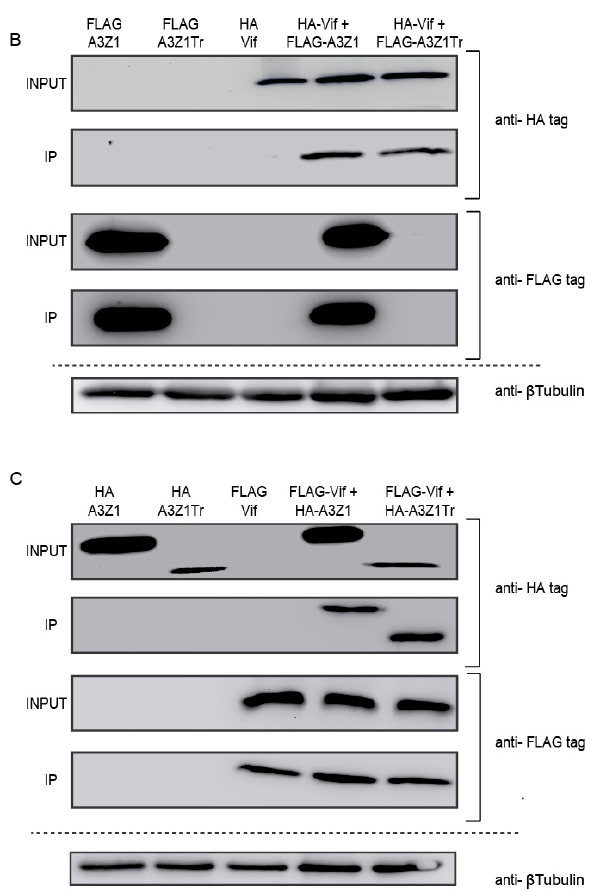
Figure 5. APOBEC3 resistance to MVV Vif. ( A ) HA-tag detection after 48 h in 293T cells co-transfected with 1 µg of plasmids expressing A3Z1 (upper panel), A3Z1Tr (middle panel) or A3Z2Z3 (down panel) with different concentrations of Vif plasmid; ( B ) 293T cells were co-transfected with plasmids expressing Vif-HA tagged and A3Z1Tr or A3Z1 tagged with FLAG epitopes and after 48 h were immunoprecipitated with anti-FLAG beads. Input lysates and co-immunoprecipitated samples (IP) were immunoblotted by anti-HA or anti-FLAG monoclonal antibodies; ( C ) reverse pull-down experiment, 293T cells were co-transfected with plasmids expressing Vif tagged with FLAG and A3Z1Tr or A3Z1 tagged with HA epitopes and after 48 h were immunoprecipitated with anti-FLAG beads. Input lysates and co-immunoprecipitated samples (IP) samples were immunoblotted by anti-HA or anti-FLAG monoclonal antibodies. β -tubulin blot was used as loading control. IP: Immunoprecipitation. INPUT: Input sample.